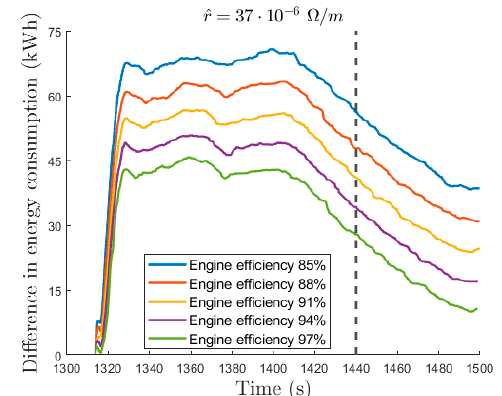
Figure 7. Difference in energy consumption (in kWh) between the considered driving strategies at the electrical substations for the Calatayud–Zaragoza section for different values of the catenary linear resistance 𝑟̂ .